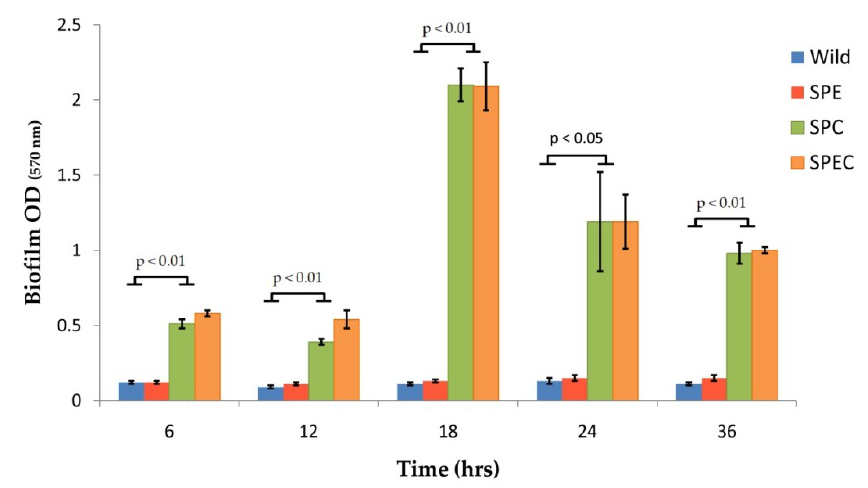
Figure 3. Biofilm formation capacities of S. pneumoniae D39 wild-type, SPE, SPC, and SPEC gene-disrupted mutantstrains in a 96-well microtiter plate as measured by the OD 570 values following crystal violet staining. Biofilm formation between the groups was assessed by analysis of variance (ANOVA) and post-hoc test. Abbreviations used: wild, S. pneumoniae D39 wild-type strain; SPE, S. pneumoniae D39 ( endA::aphA3 ) knockout strain; SPC, S. pneumoniae D39 ( cpsE::tetL ) knockout strain; SPEC, S. pneumoniae D39 ( cpsE::tetL ; endA::aphA3 ) double-knockout